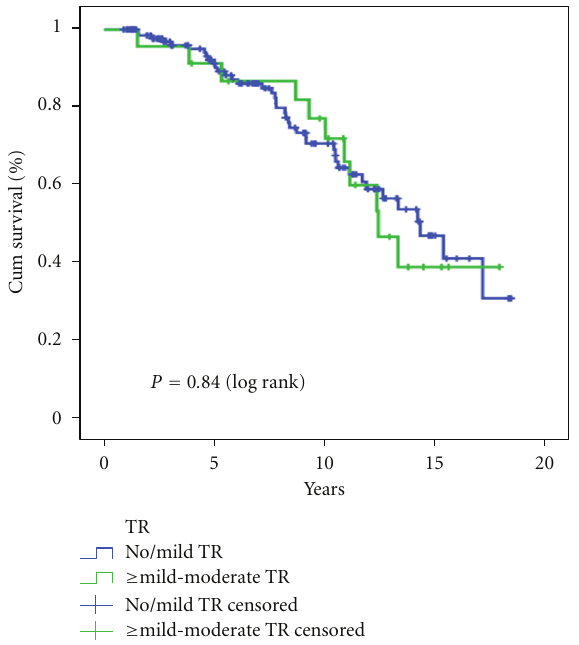
Figure 3: Kaplan-Meier survival analysis of both study groups. TR, tricuspid